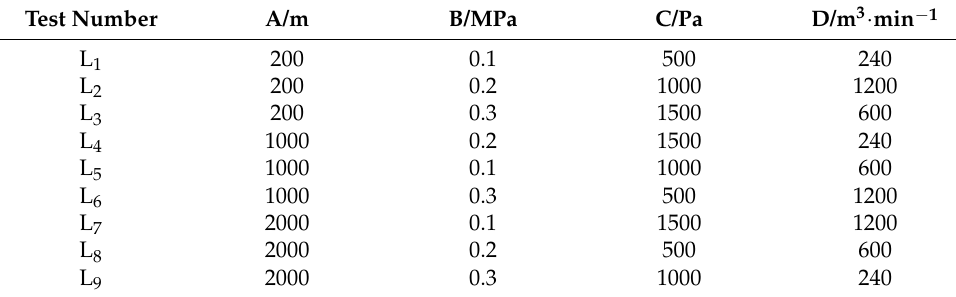
Table 1. Initial parameters of the orthogonal